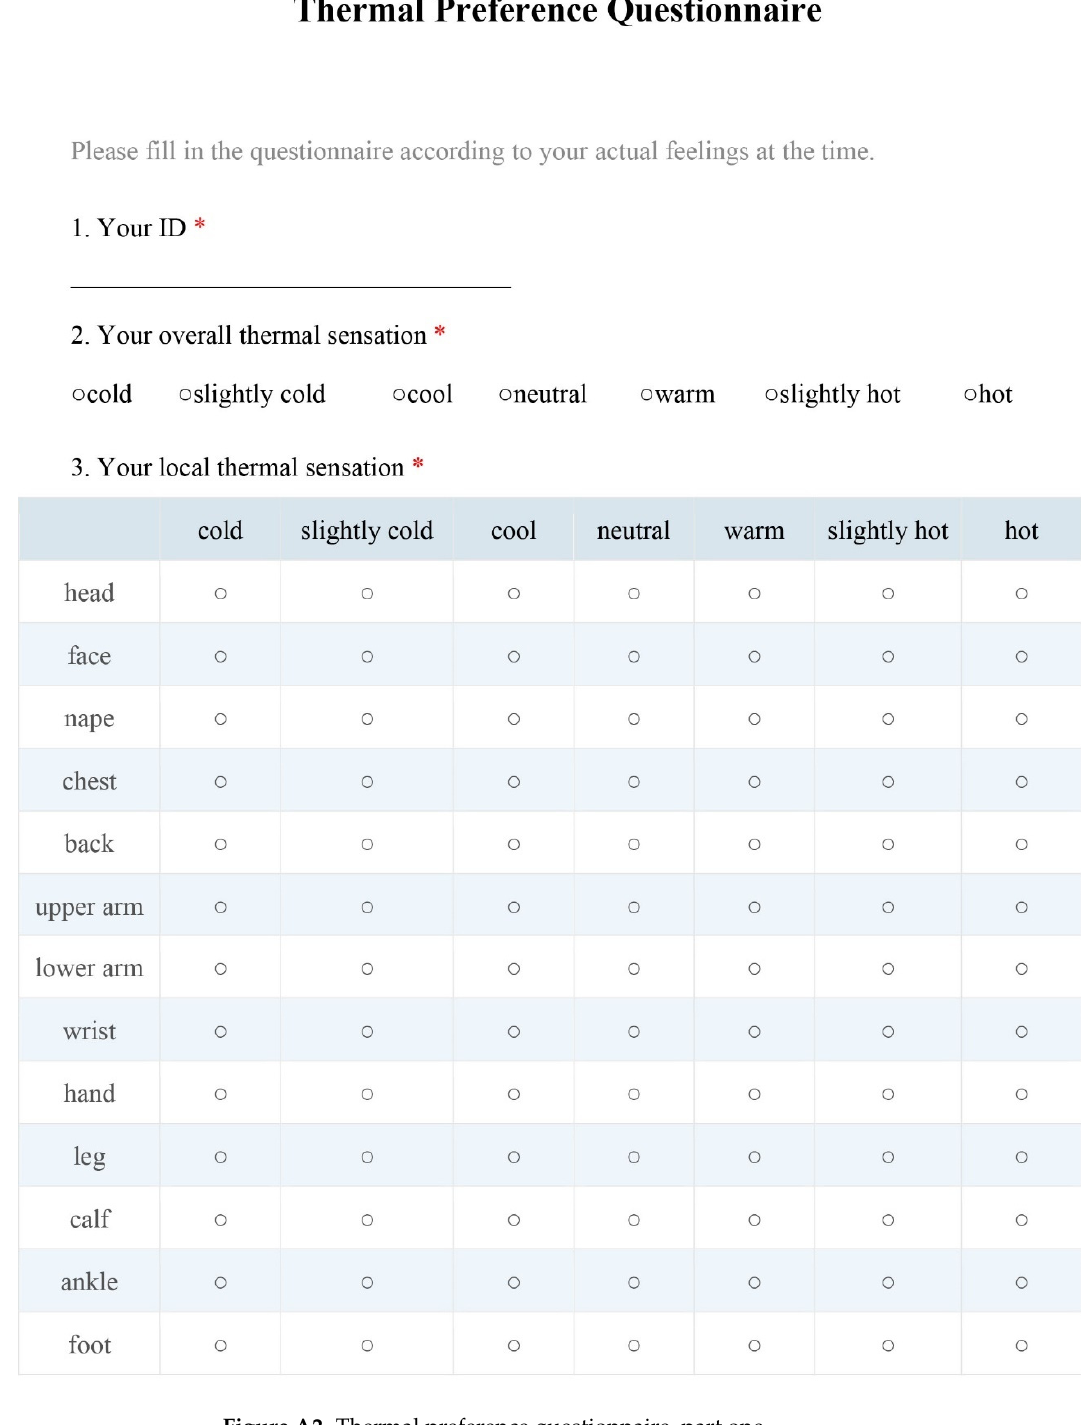
Figure A2. Thermal preference questionnaire, part one.